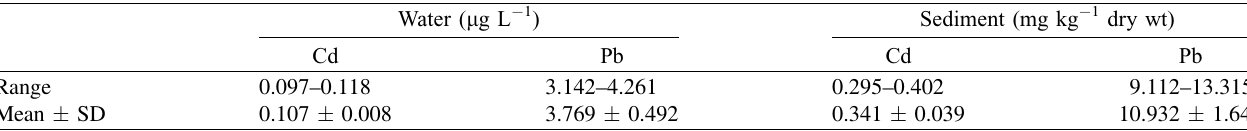
Table 2. Range and mean Cd and Pb concentrations in the water and sediments at fi ve sites in El-Mena Bay (Red